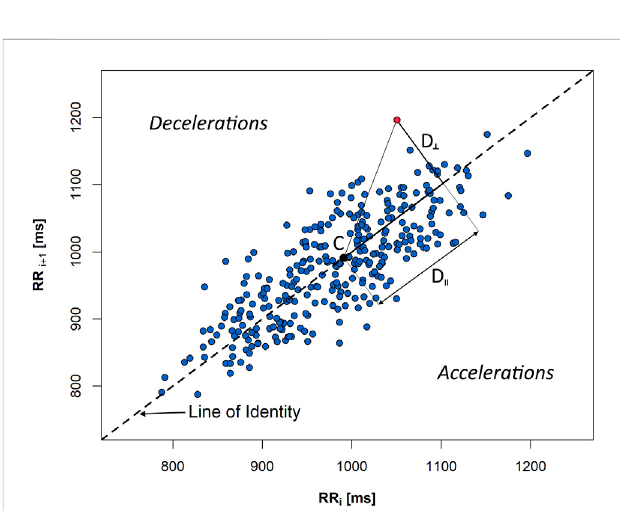
FIGURE 2 A Poincaré plot of a 5-min sequence of heartbeat intervals (RR) extracted from an ECG recording of a healthy person in supine. D (cid:1) and D ⊥ are, accordingly, in parallel and perpendicular distances, with regard to theline of identity, from the given plot point (red) to the centroid (C) of the fi gure created by all the points from the